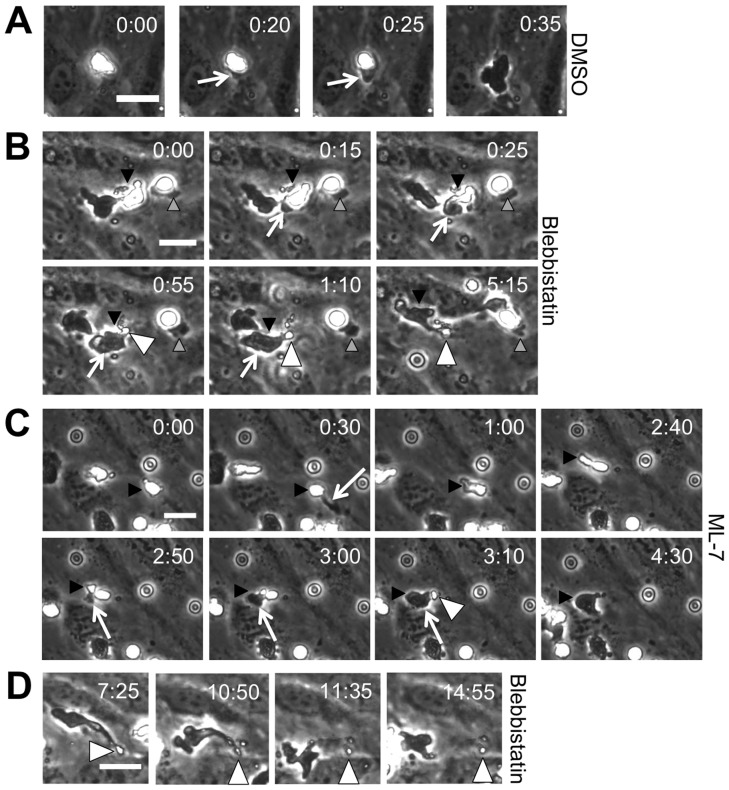
Incomplete transmigration upon inhibition of contractility.(A) A representative phase contrast sequence of a DMSO-treated neutrophil transmigrating through the endothelium on a 5 kPa gel. The neutrophil on top of the endothelium appears bright white in phase contrast microscopy, while the portion that has already transmigrated through the endothelium appears dark (white arrow). (B) A representative phase contrast sequence of blebbistatin-treated neutrophils transmigrating through the endothelium. Black arrowhead points to the first cell of interest. White arrows point to the darkened portion of the neutrophil under the endothelium. White arrowheads point to the portion of the tail that remains above the endothelium for several minutes after the rest of the neutrophil has transmigrated. Gray arrowheads point to another neutrophil that attempts to transmigrate, but does not ever fully succeed. For panels A and B, time = 0:00 (in minutes∶seconds format) in the upper right corner of the first image in each sequence indicates the time of the frame just before transmigration begins. (C) An example of an ML-7-treated neutrophil (indicated by black arrowhead) that makes two attempts at transmigration. A protrusion is sent beneath the endothelium (designated by white arrow at 0:30), but the neutrophil does not transmigrate on this attempt. Later, at time = 2:50 the neutrophil begins to transmigrate again (designated by white arrows in images 2:50–3:10). Similar to blebbistatin, a tail is left behind (white arrowhead at 3:10), but full transmigration, including the tail, occurs by time = 4:30. Scale bar for the first image in each sequence is 20 µm. (D) A time sequence is shown for a blebbistatin-treated neutrophil that transmigrates, leaves a tail behind, and later detaches from the tail. Time after plating neutrophils is shown in the upper right corner of each image in minutes∶seconds fomat. Scale bar in panel D is 20 µm and applies to all images in panel D.